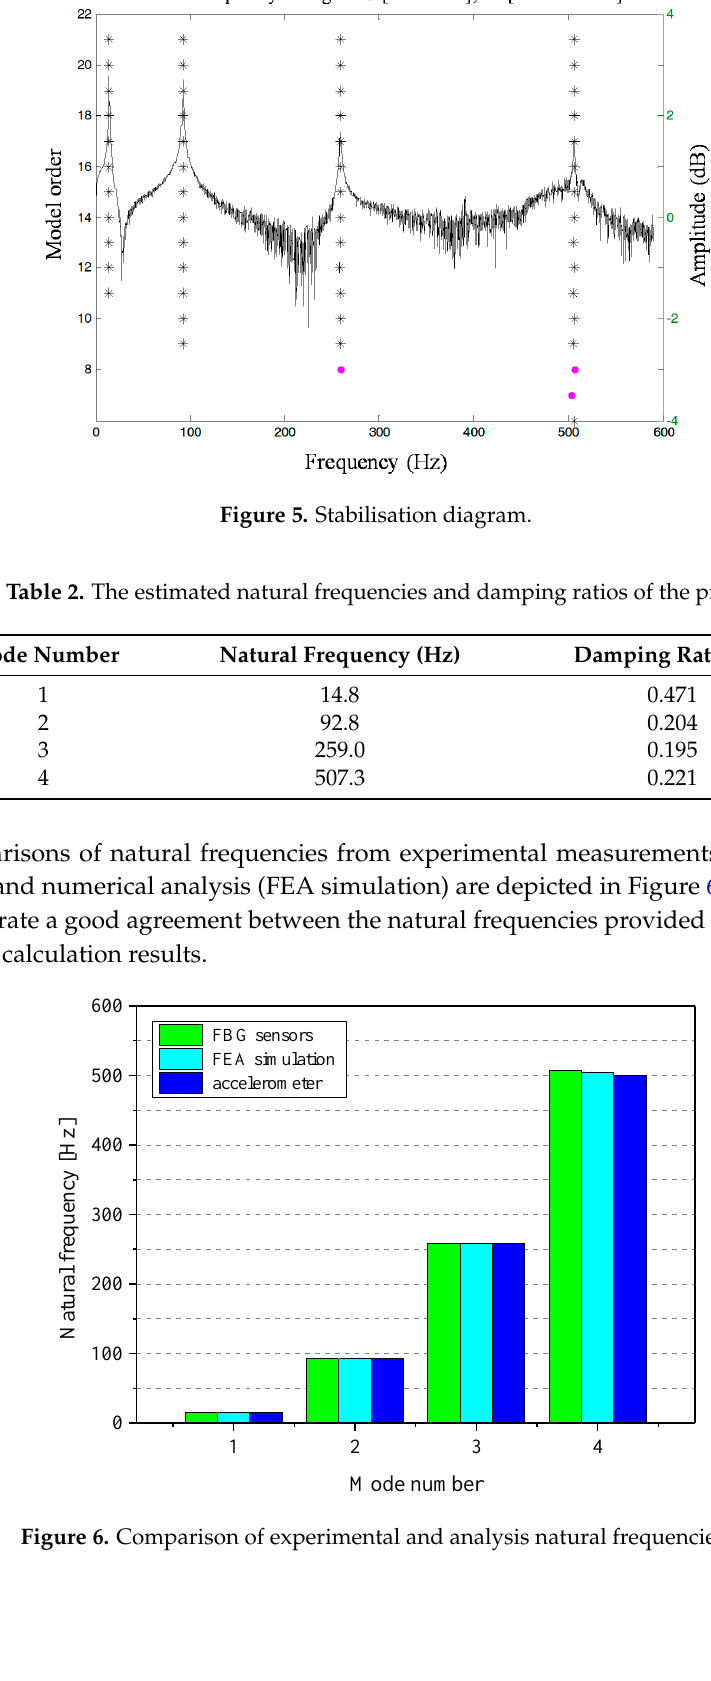
Figure 7. Comparison of normalised strain mode shapes between the results of FEA simulation and experiment , t he strain mode shapes along the Z direction of the pipe: ( a ) mode 1; ( b ) mode 2; ( c ) mode 3; ( d ) mode 4. Modal assurance criteria (MAC) are usually employed to determine the quality of the measured mode shapes, which ranges between 0 and 1 [23]. If the value of the MAC is close to 0, then there is little correlation between the two modes. However, if the value of the MAC approaches 1.0, it means that the two modes are highly correlated and almost identical. The correlation of the strain mode shapes between experimental testing by FBG sensors and FEA calculation (shown in Figure 7) was calculated using the MAC and the results are shown in Figure 8. The diagonal MAC values are close to 1.0, and the non-diagonal values are nearly close to zero. It is indicated that there is a high correlation between the two strain mode shapes (acquired by experiments using FBG sensors and FEA simulation), and the experimental modal testing results by the FBG sensors are accurate and reliable.